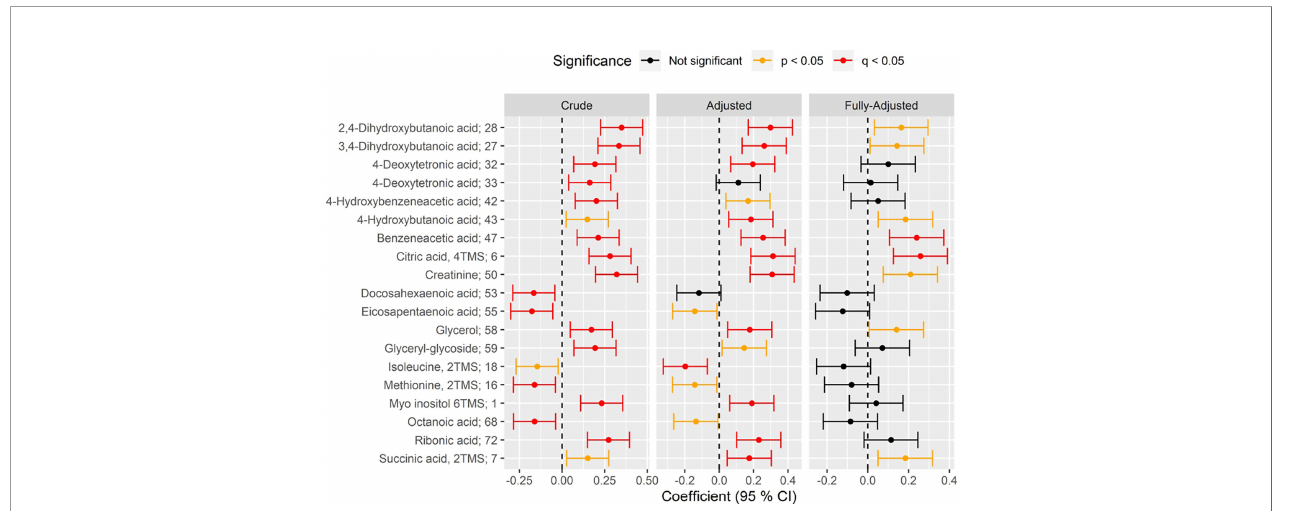
FIGURE 2 | Forest plot of standardized association between CAN vs no CAN and circulating metabolite level in crude (left), adjusted (middle) and fully-adjusted (right) metabolite-speci fi c regression models (rows). Positive (negative) coef fi cient on the x-axis indicates positive (inverse) association between CAN and metabolite level. Statistical signi fi cance of the association is indicated by color of the con fi dence 95% interval (red: signi fi cant after correction to multiple testing(q); orange: signi fi cant nominal p-value(p); black: not signi fi cant). Results are shown for crude models (unadjusted; left), for models adjusted for age, sex, plasma glucose, HbA 1c , body mass index, diabetes duration, smoking, statin use, total cholesterol and total triglycerides ( “ Adjusted ” ; middle) and models further adjusted for eGFR ( “ Fully- Adjusted ” , right). All signi fi cant associations (q<0.05) in at least one of the three models, have been